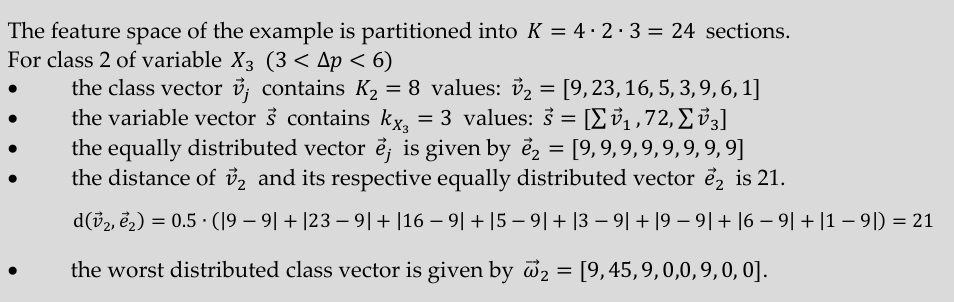
Figure 6. Schematic visualization of the feature space of a three-dimensional data set and illustration of selected parameters [gray box] ( a ) class 2 of variable X 3 is highlighted ( b ) two-dimensional scatter plot of class 2 of variable X 3 ( c ) class 3 of variable X 1 is highlighted ( d ) class 2 of variable X 2 is highlighted.